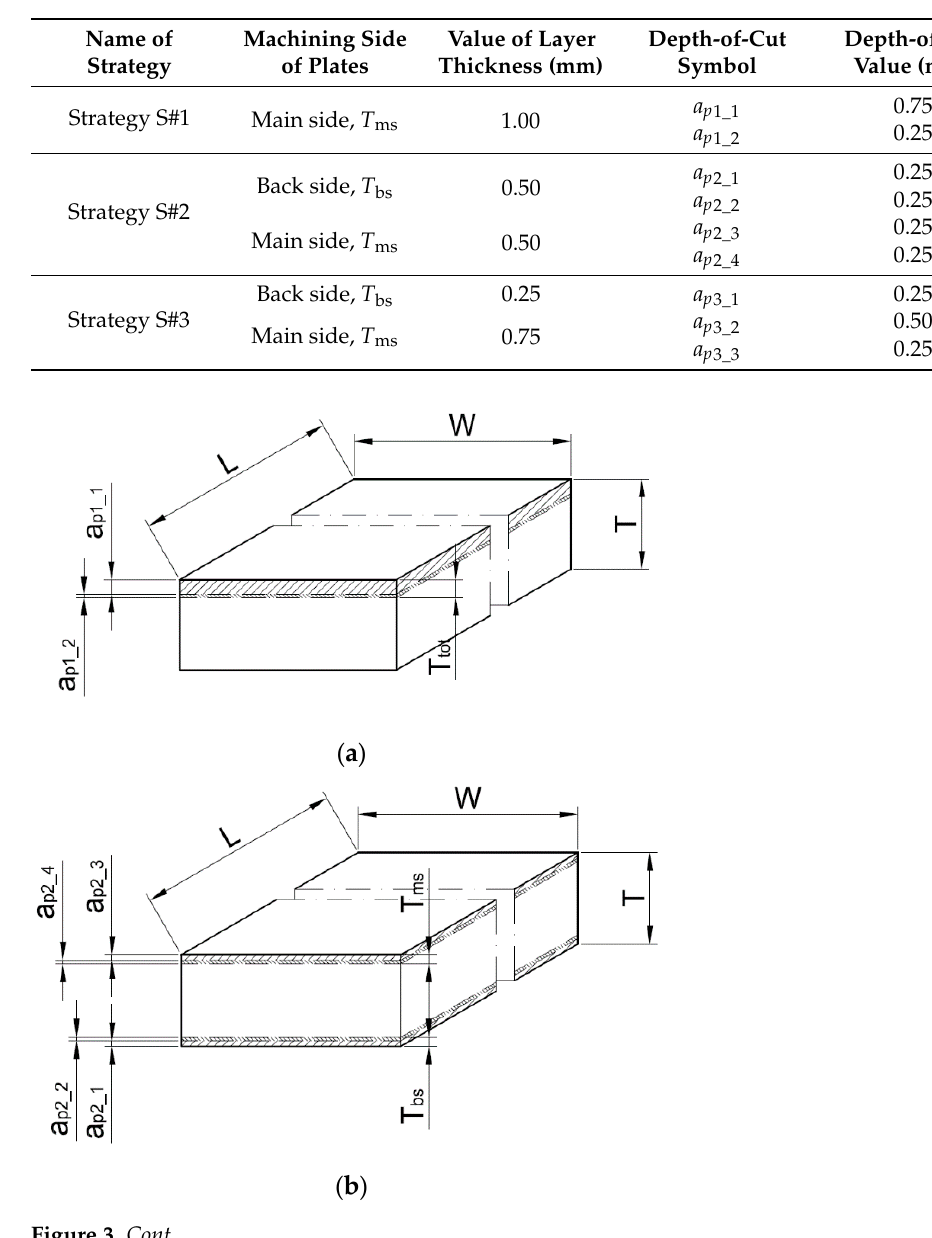
Table 4. Depths of cut for investigated strategies.